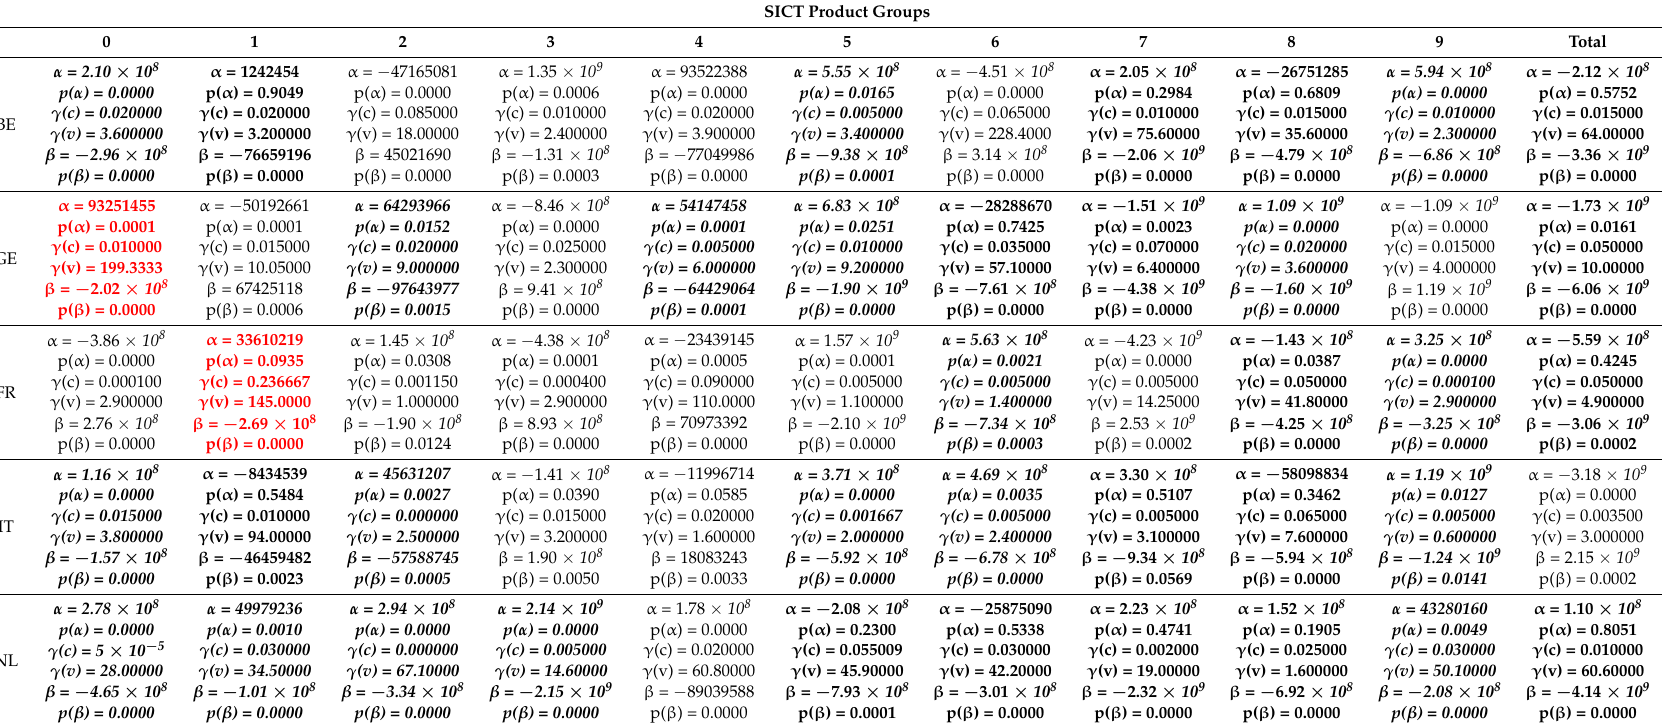
Table A1. Hysteresis with a variable play area (exchange rate